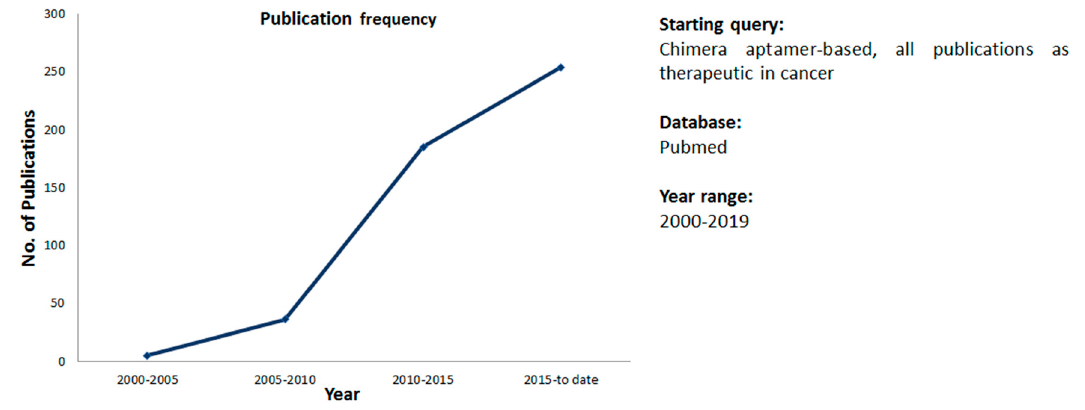
Figure 1. Aptamers chimera in cancer therapy: Publications trend. Pubmed advanced research using the following criteria (((((chimera) OR conjugate) AND cancer) AND aptamer) AND therapy) AND (“from”[Date—Publication]: “to”[Date—Publication]) Sort by: Best Match.